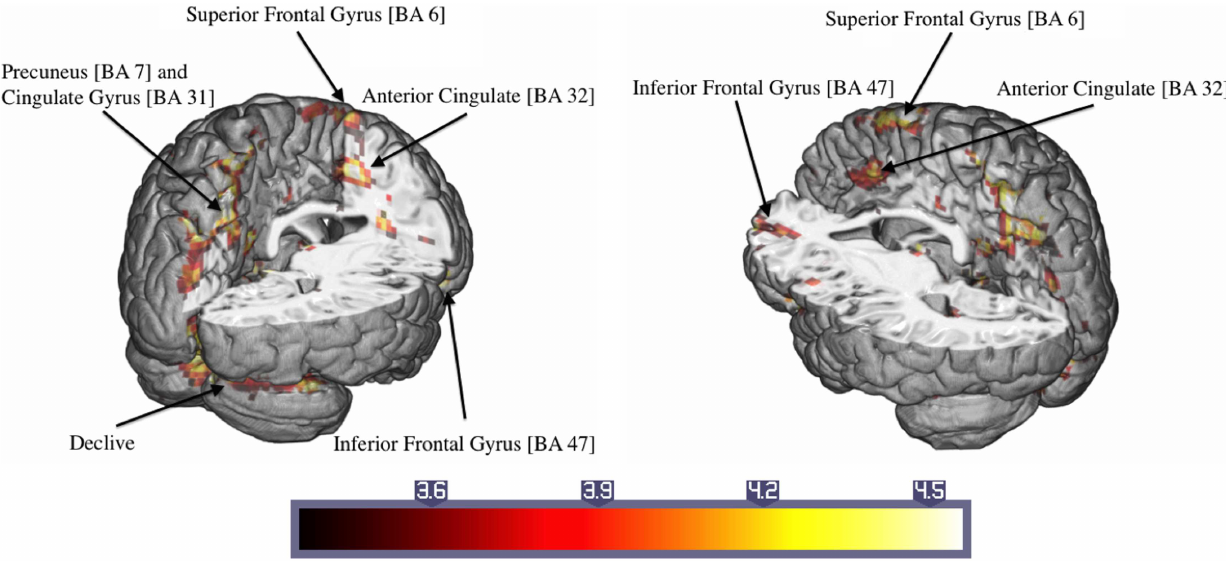
FIGURE 3 | Significant activations of the response to trauma-related compared to neutral pictures inASD patients (numbers in brackets indicate Brodmann areas)